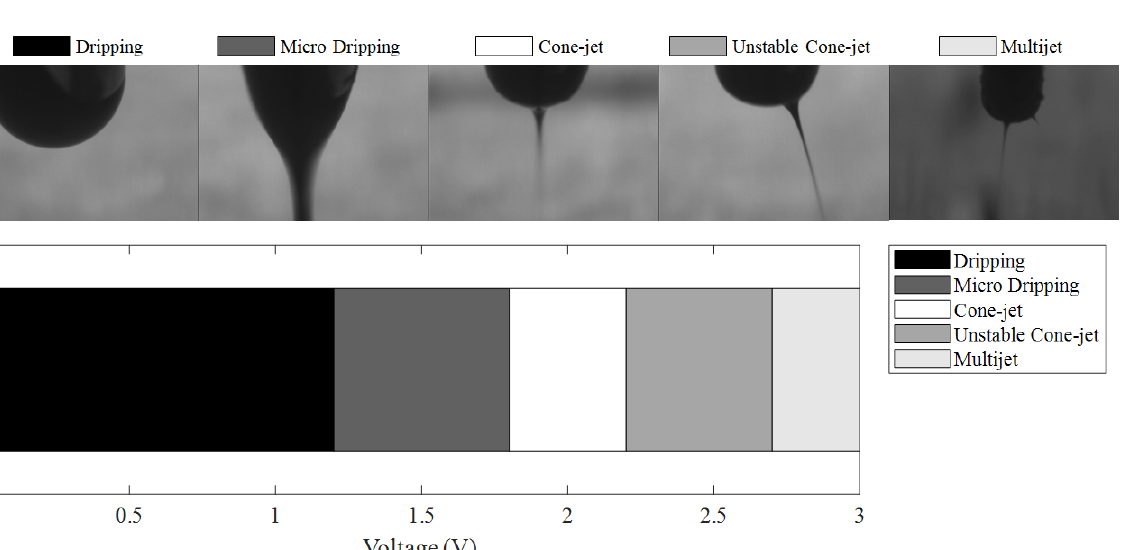
4 of 10 Figure 2. ( a ) System schematic diagram of EHD ink-jet printing. ( b ) Principle of EHD ink-jet print-